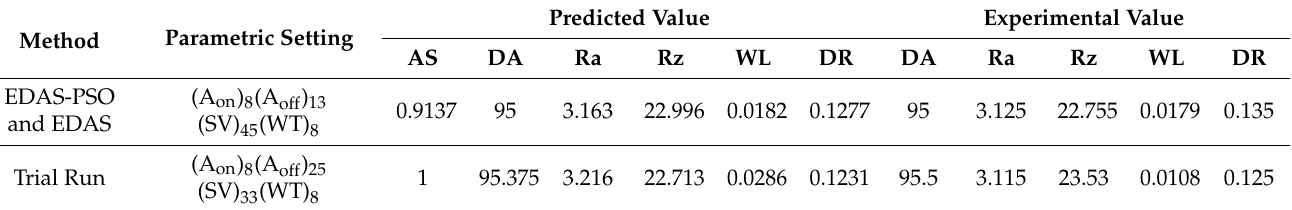
Figure 7. Pareto-optimal front after PSO. Table 12. Validation experiments.